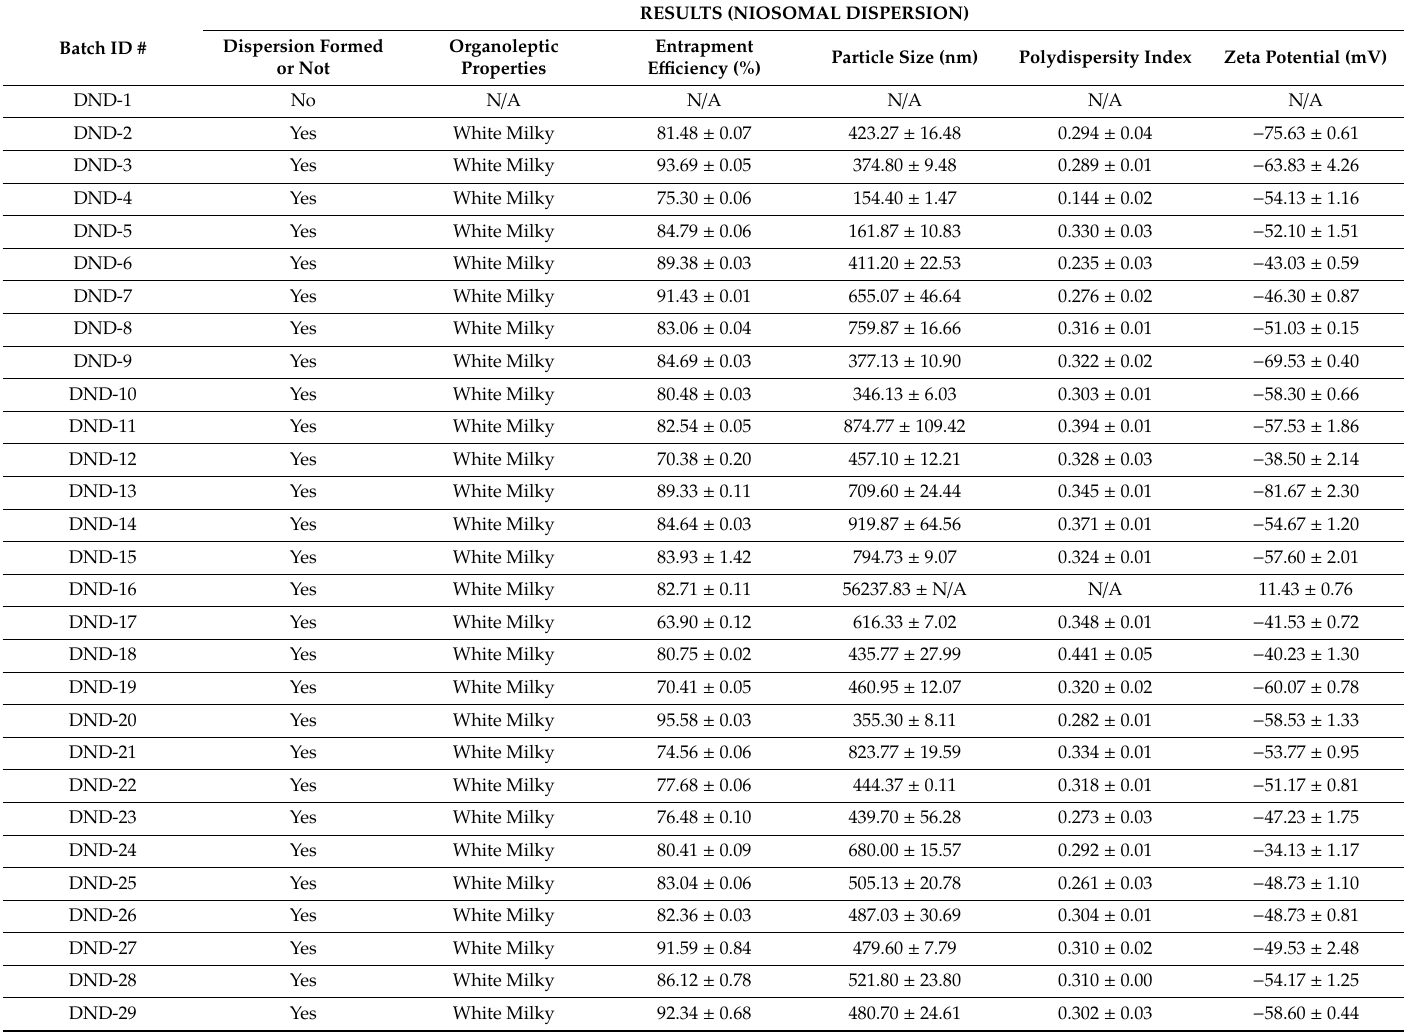
Table 3. Summary of Results for QbD—Niosomal